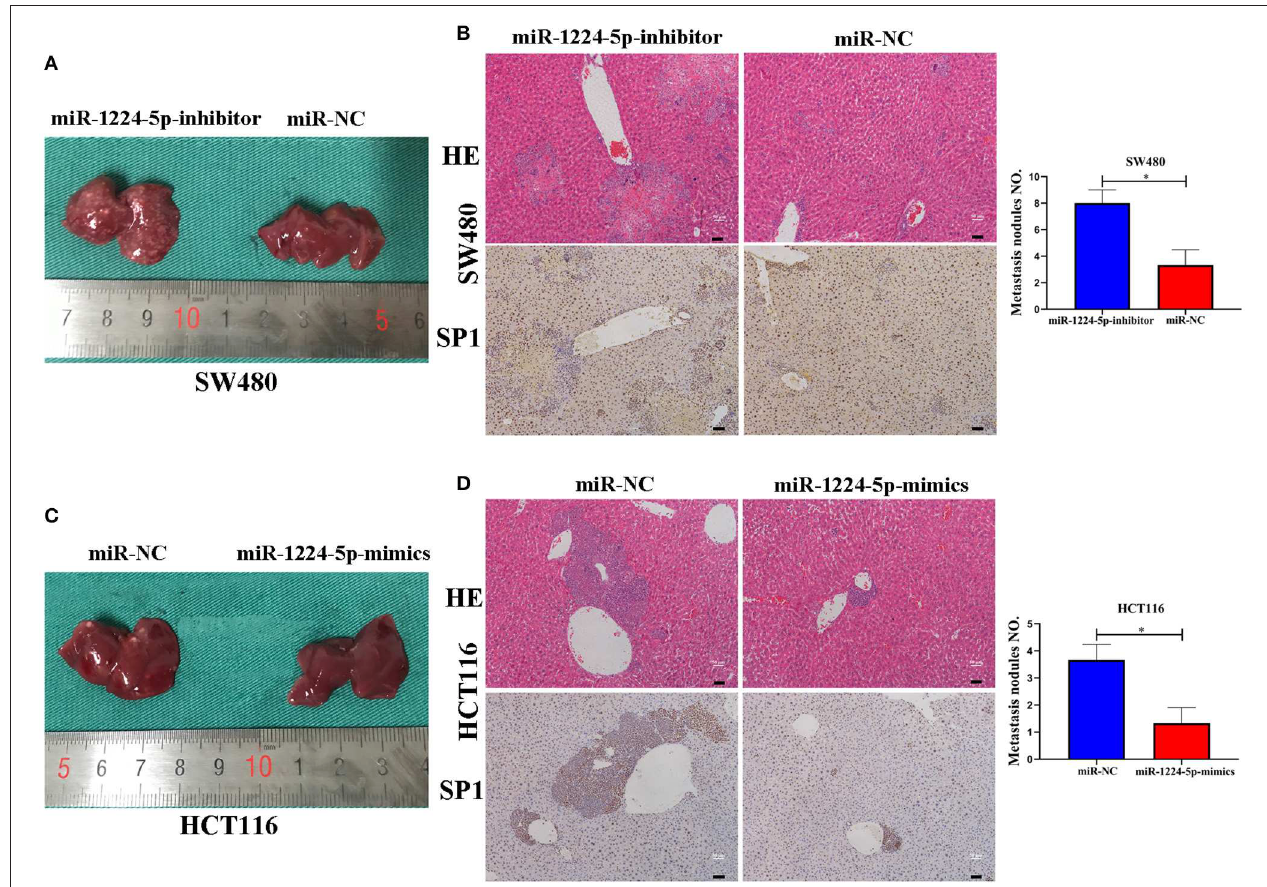
FIGURE 7 | miR-1224-5p inhibits the liver metastasis of CRC cells in vivo . (A,C) . Representative photograph of liver metastases obtained from nude mice transfected with miR-1224-5p-inhibitor, miR-1224-5p-mimics, and miR-NC. (B,D) . HE staining and immunohistochemistry of liver metastases in miR-1224-5p-inhibitor, miR-1224-5p-mimics, and miR-NC, scale bars: 50 µ m (B,D) . Data represent the mean ± SD from three independent experiments. Student’s t -test was used to determine statistical significance: * p <